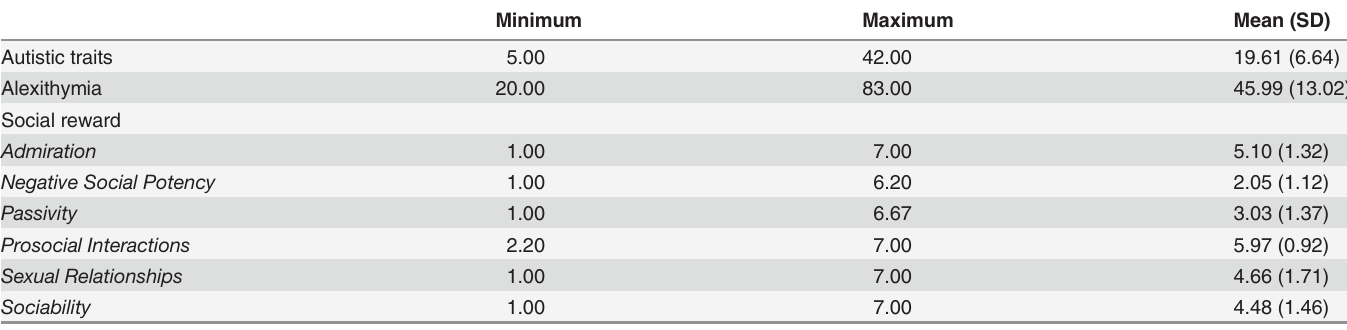
Table 1. Descriptives for all questionnaire measures.